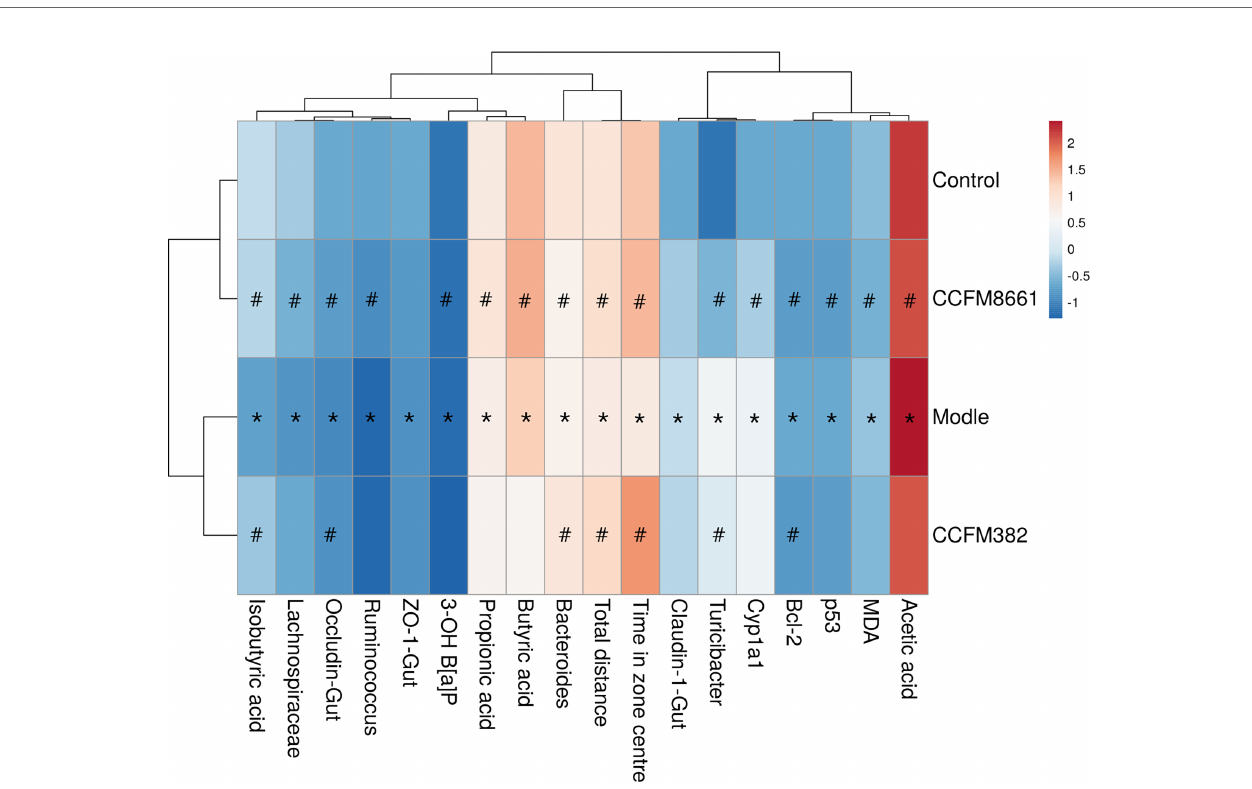
FIGURE 8 | Clustered heat map of the parameters signi fi cantly affected by B[a]P and L. plantarum CCFM8661 treatment. Red indicates an increase in the corresponding group and blue indicates a decrease in the corresponding group. The asterisks indicate signi fi cant difference between control and model groups ( P < 0.05 ). The pound signs indicate signi fi cant difference between model and L. plantarum intervention groups ( P < 0.05